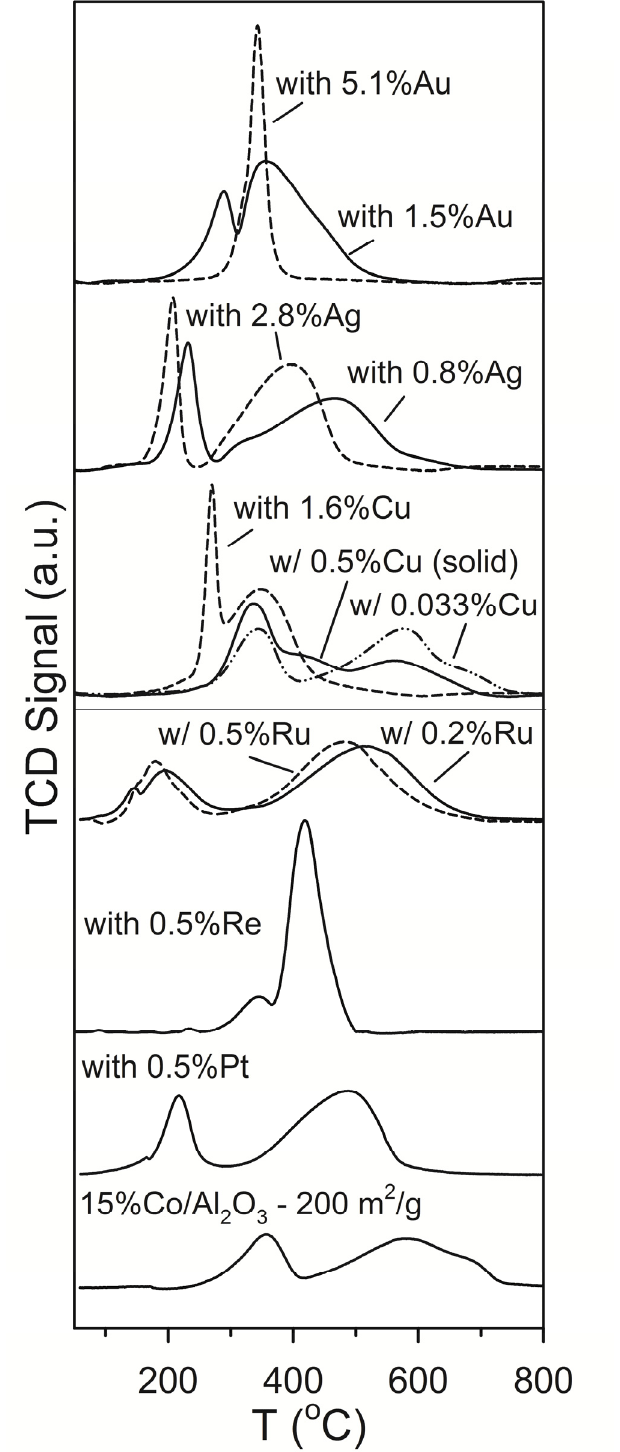
Figure 1. TPR profiles demonstrate the effectiveness of Cu for facilitating reduction of cobalt oxides. Curve labels: unpromoted 15%Co/Al 0.033%Cu (thick dashed), 0.49%Cu (thin solid), and 1.63%Cu (thin dash-dotted) by weight. (Reproduced with permission from [7] and [10] Copyright 2002, 2009,